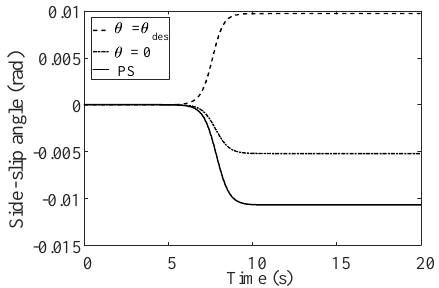
Figure 11. Side-slip angle of the vehicle center of